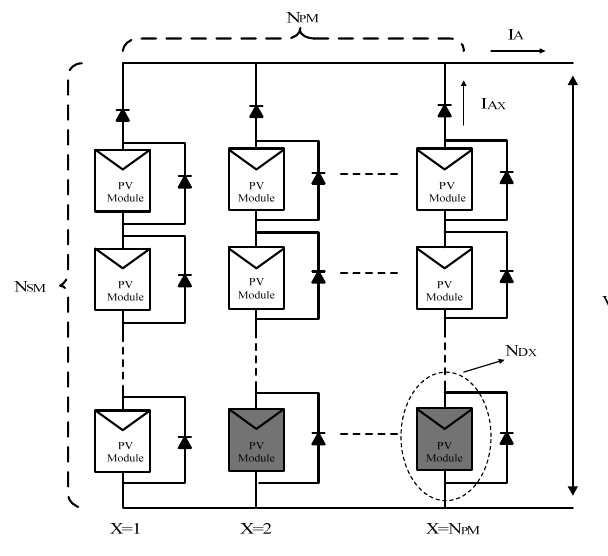
Figure 2. SP configuration of PV array.